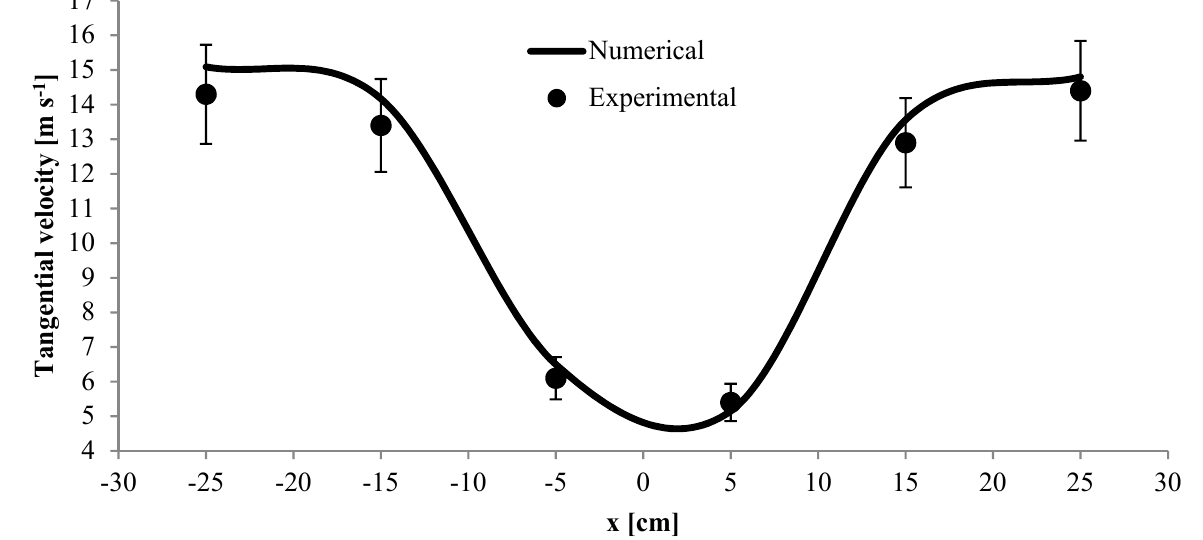
Figure 5. Validation procedure for tangential velocity with error bars of 10%.